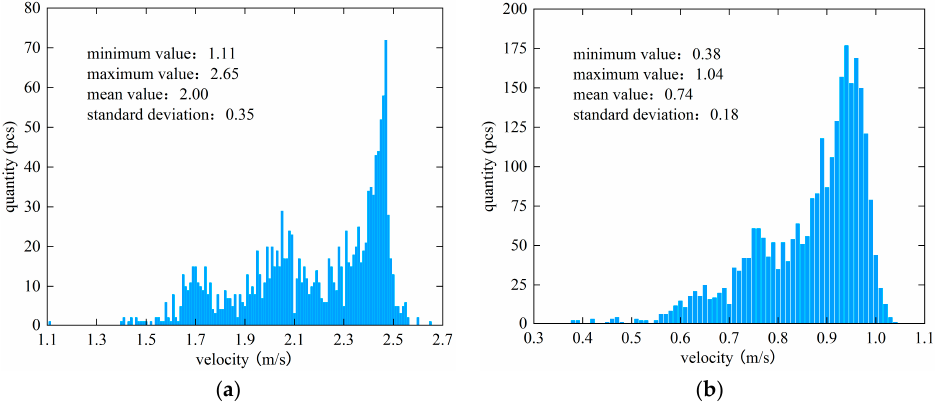
Figure 7. Statistical histogram of ice plane velocity ( a ) 16:00, 25 April 2021; ( b ) 8:00, 26 April 2021.